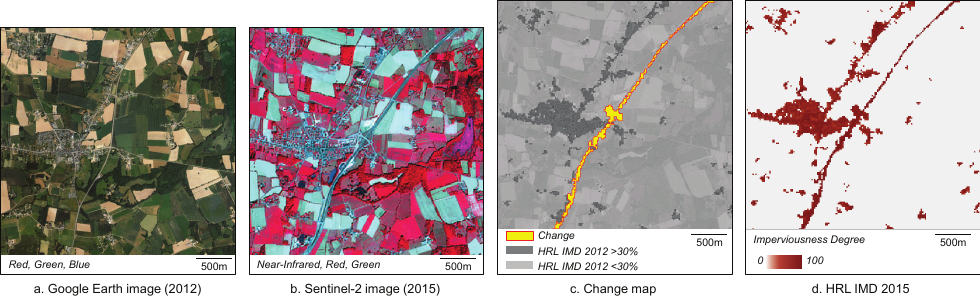
Figure 14. Detection of a new motorway in Rennes (yellow: changes; dark grey: HRL IMD 2012 >30%; light grey: HRL IMD 2012 <30%). ( a ) Google Earth image (2012); ( b ) Sentinel-2 image (2015); ( c ) Change map; ( d ) HRL IMD 2015.